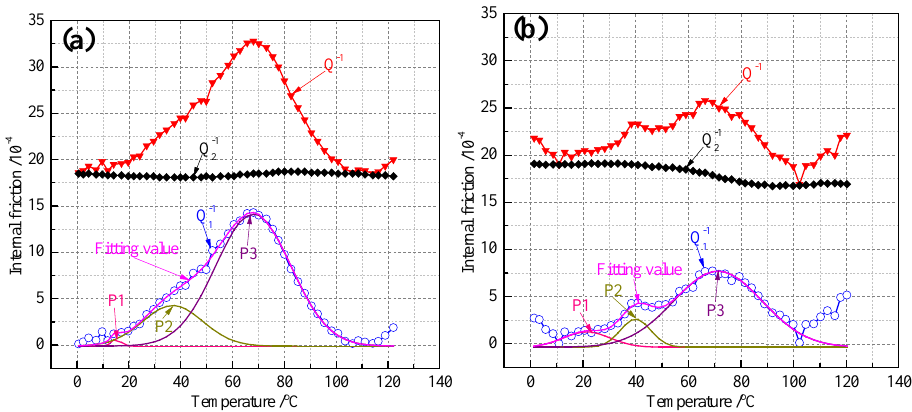
Figure 8. Internal friction spectra of different C content: ( a ) ELC; ( b ) LC. In the binary Fe-C alloy, the height of the Snoek peak (Q − 1 ) is assumed to be directly proportional to the solid solution atonic content ([C]) [24]. That is, max−1 Q Here, K is a factor which depends on the grain size, substitutional alloying element and the texture of the alloy. In this experiment, K is recommended to be 1.33 for solid solution carbon atoms and 1.28 for solid solution nitrogen atoms, this value is similar to that in other literatures [26,27]. The solid solution carbon atom content of ELC at P3 is significantly higher than that of LC. The reason is that the long of layer cooling line in ESP is about 40 m and that in the conventional hot rolling line is about 120 m. Therefore, high cooling speed results in supersaturated solution of carbon atoms in ultra-thin strip steel. It is considered that there are two reasons why the content of solid solution carbon atoms in ELC is higher than that in LC. One is that LC undergoes eutectoid transformation to form pearlite, the carbon atoms dissolved in or near the pearlite field are easy to diffuse to the lamellar cementite and precipitate in the form of Fe 3 C III because of the short distance. The other is that the ferrite grains of LC are relatively small, and the content of dissolved carbon in ferrite is nearly twice that of ELC, so these solid solution carbons are also easier to diffuse to the ferrite grain boundary and precipitate in the form of Fe 3 C III or take heterogeneous points as the nucleation core to precipitate spherical cementite in ferrite grains, as shown in Figure 4. The activation energy (H) can be calculated [28] by: